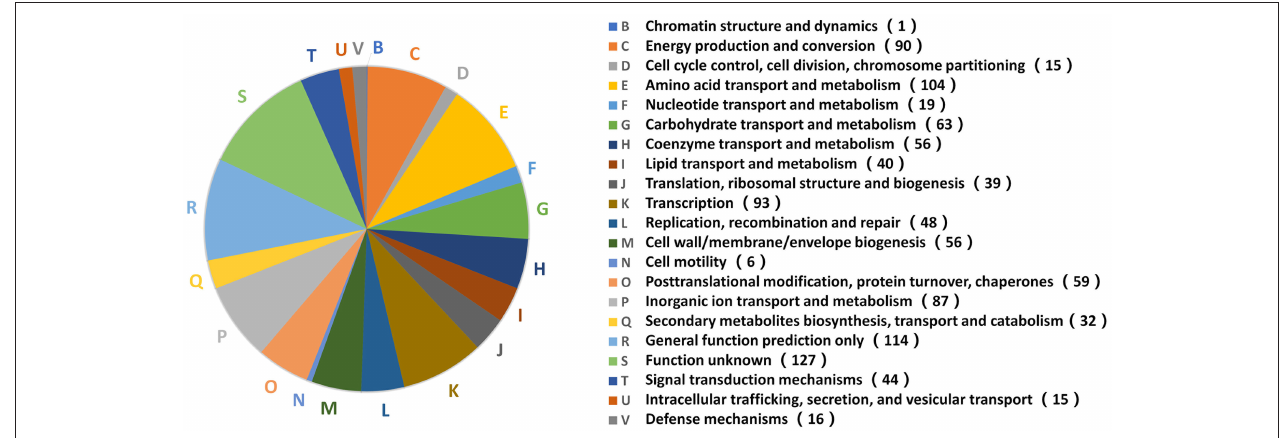
FIGURE 4 | Distribution of 1,221 DEPs in the stress treatments according to COG functions. A phylogenetic classification of DEPs in response to environmental stress was accomplished using the clusters of COGs. Letters displayed on the pie chart represent individual COGs with the numbers of proteins listed in brackets